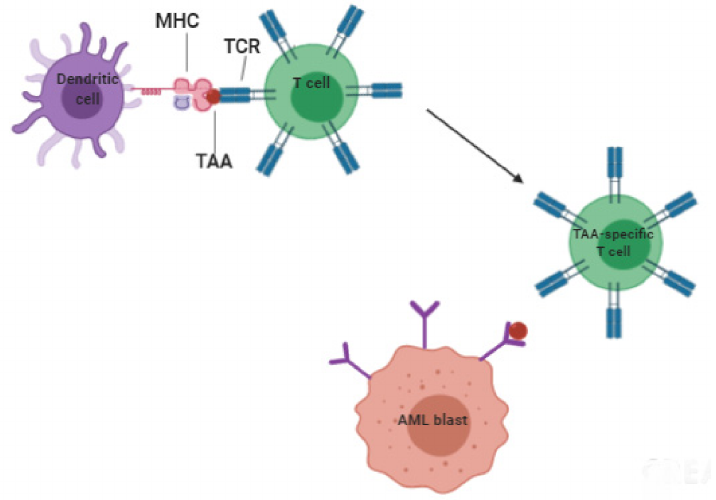
Figure 3. Schematic representation of T cell responses toward AML tumor-associated antigen (TAA). DCs present the MHC, loaded with AML antigen peptides, to the TCR of T lymphocytes, allowing the generation of AML-specific Tcell activation and expansion. Among AML-specific T cells, CTL will be able to recognize and kill AML cells. The figure was created with